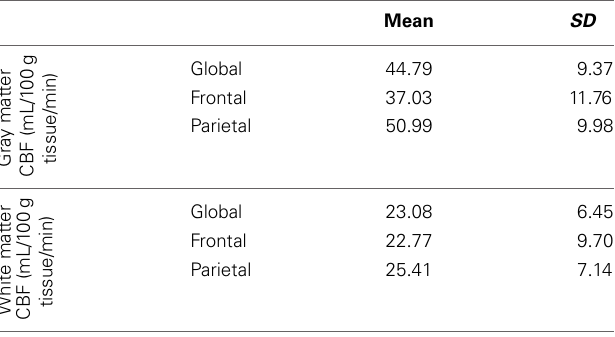
Table 2 | Mean and standard deviation of global and regional blood flow